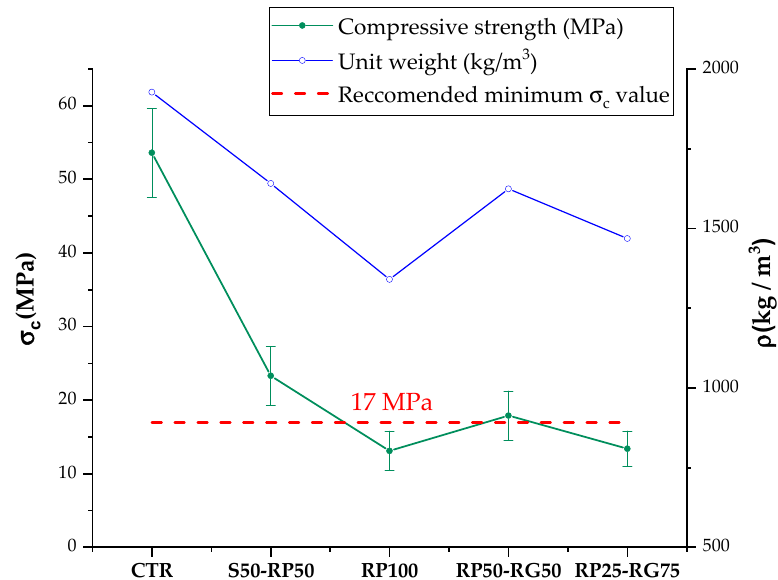
Figure 11. Compressive strength and unit weight trend: Test results.